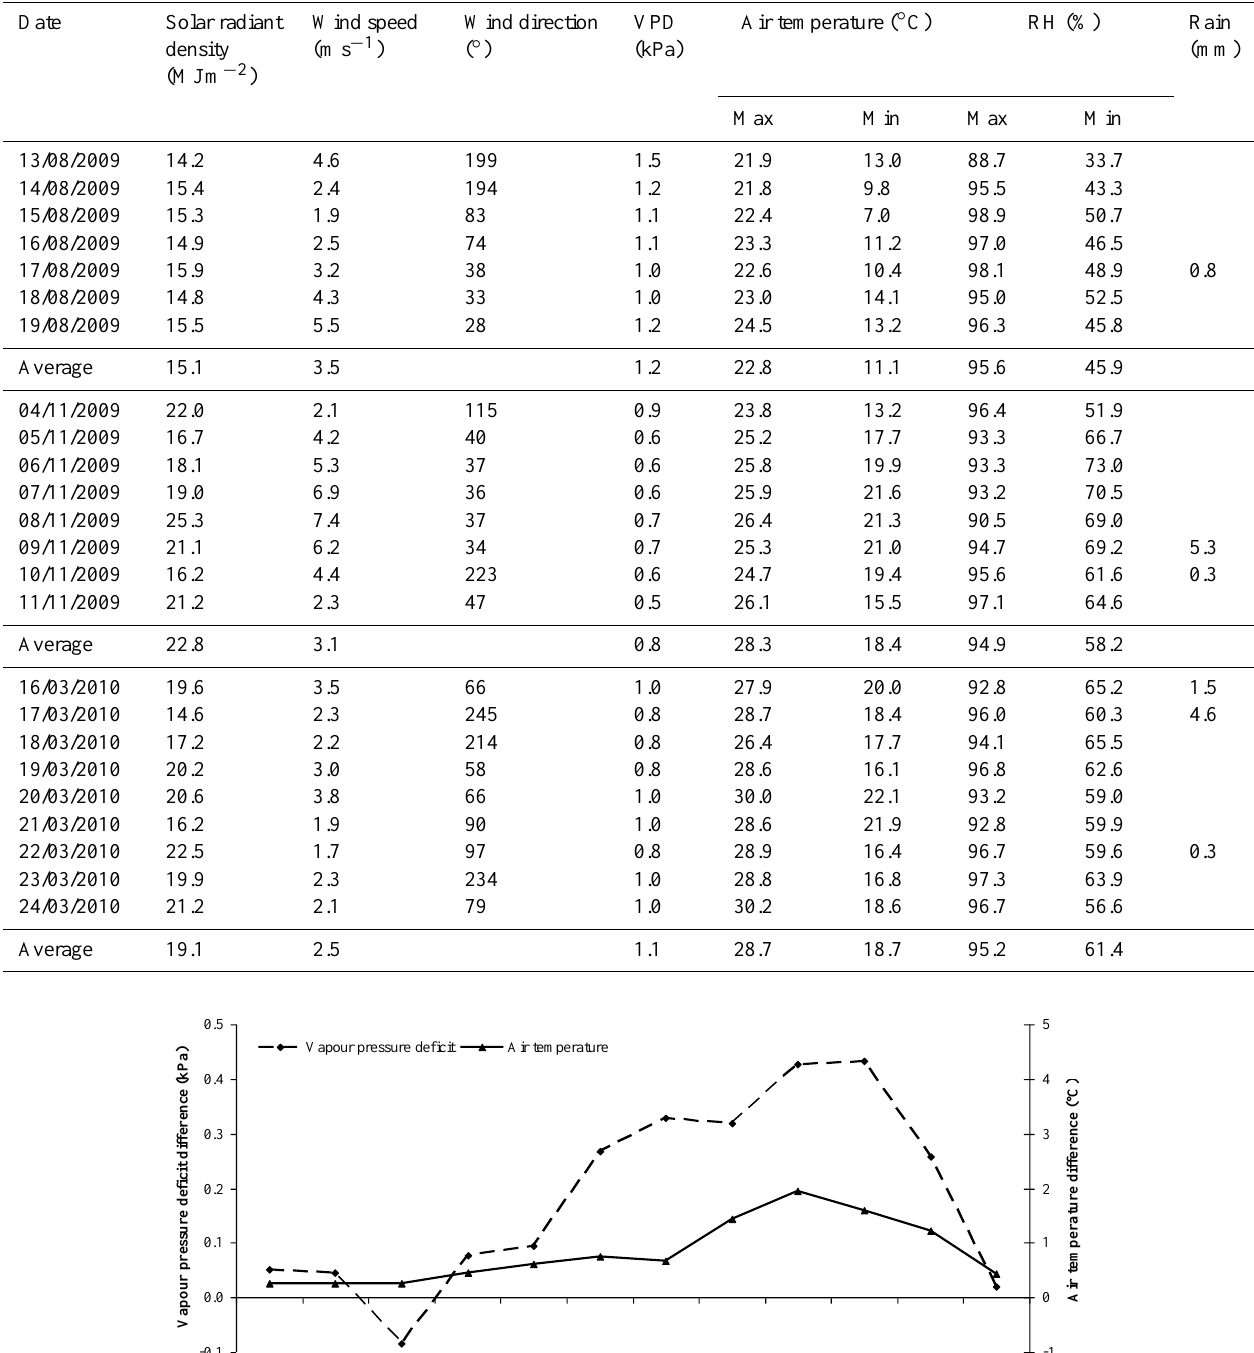
Table 1. Summary of weather conditions during the August 2009, November 2009 and March 2010 field campaigns.